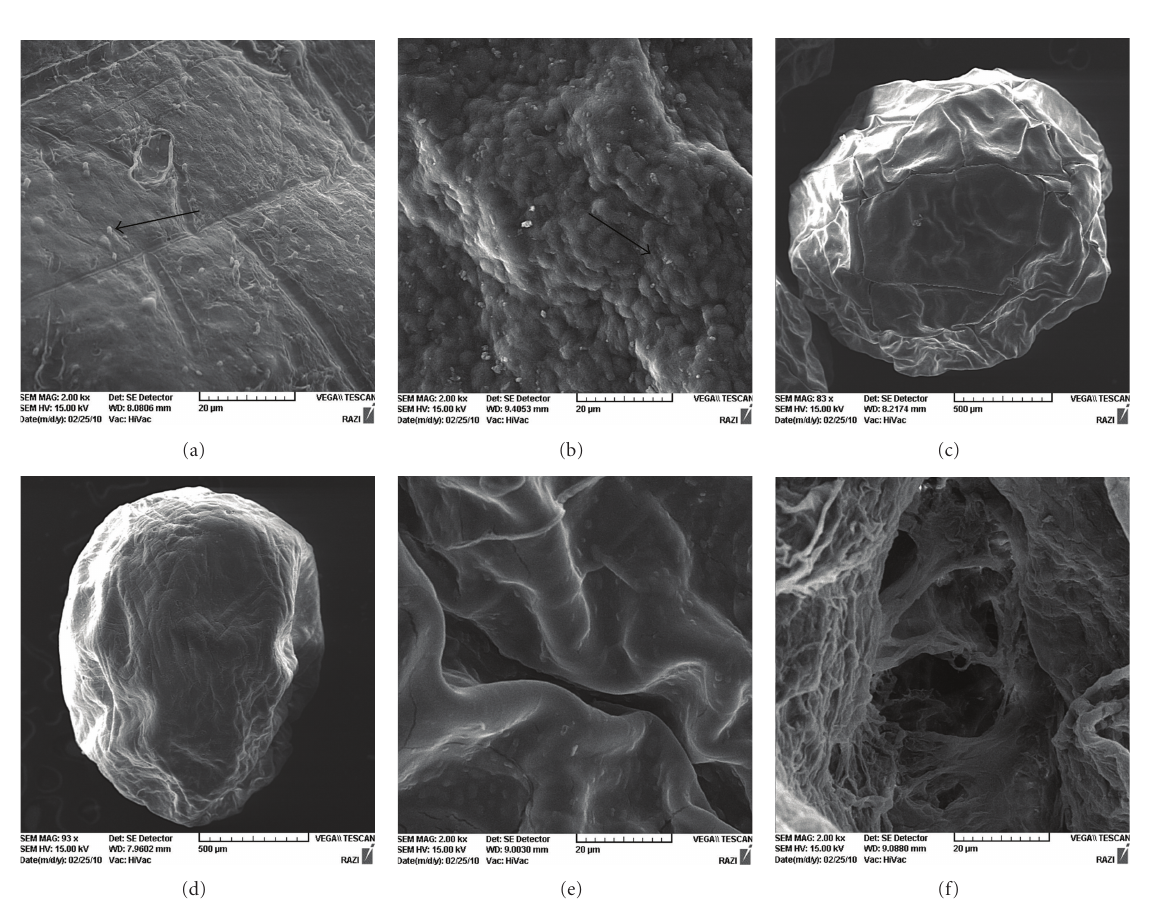
Figure 1: SEM pictures of F1 (a, c); F4 (b, d); F9 (e); F12 (f) beads at a magnification of 2000x (a, b, e, f), of 97x (c) and of 83x